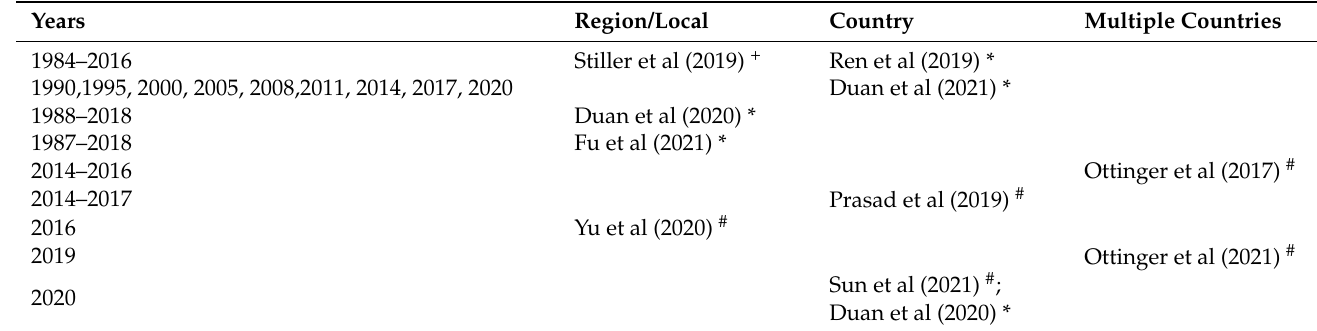
Table A1. Summary of previous studies on extraction from aquaculture